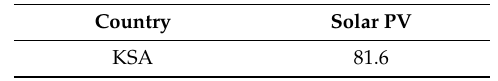
Table 5. Lower limits of installed capacities [MW] considered in this study for Saudi Arabia.